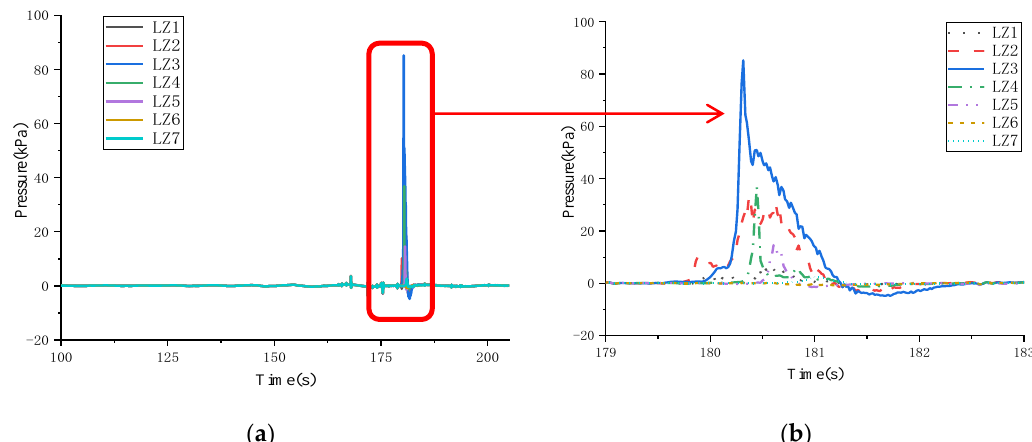
Figure 14. Pressure time series of D1 – D7 on wavefront surface of front column. ( a ) Global graphics. ( b ) Detail graphics.